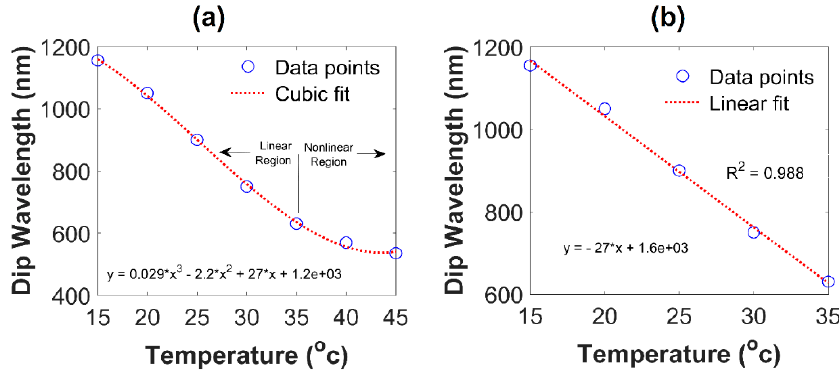
Figure 9. Dip wavelength of transmission spectra of the Sagnac interferometer optical fiber sensor as a function of ambient temperature for ( a ) linear and nonlinear regions with a temperature range of 15–45 °C and ( b ) a linear region with a temperature range of 15–35 °C.